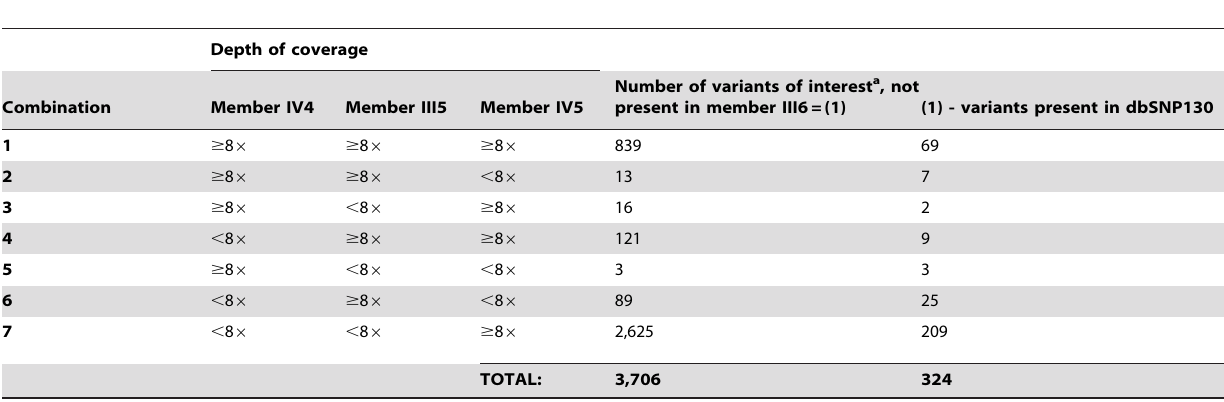
Table 3. Estimation of number of variants to be assessed by genotyping in the extended family and in